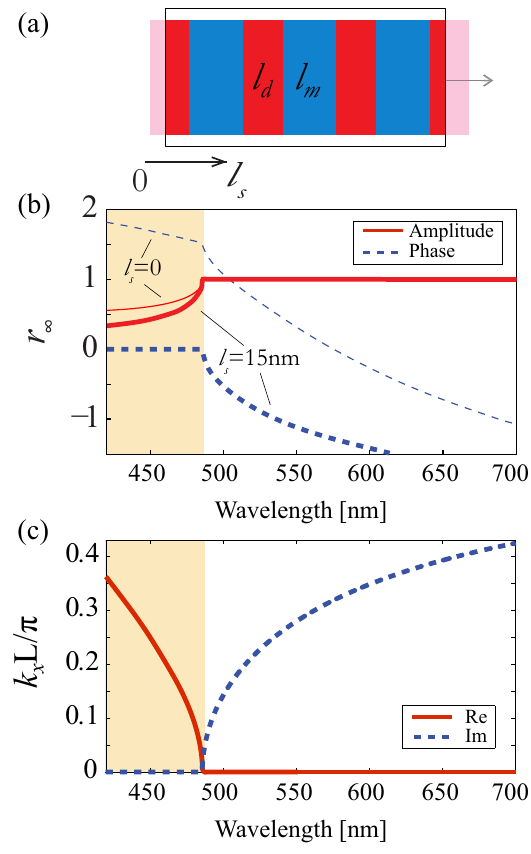
Figure 2. ( a ) Diagram of how the cycle shift operator acts. A frame of chosen length NL , N ∈ N , is cutting out the finite fragment from the infinite multilayer; ( b ) The reflection > 0 coefficient from the semi-infinite structure with ( c ) the corresponding band diagram of the multilayer. The allowed band is highlighted in ( b , c